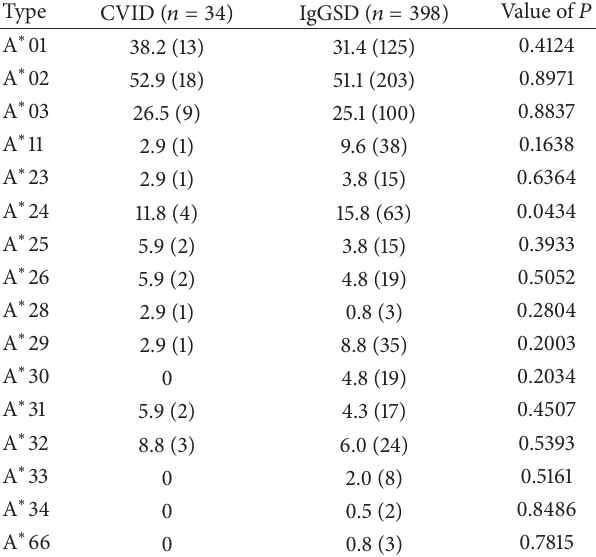
Table 5: Positivity for HLA-A types in 432 adult CVID/IgGSD index patients 1